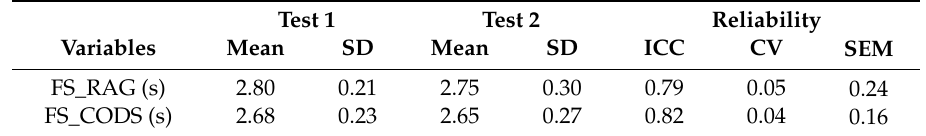
Table 1. Inter-testing reliability of the newly developed tests of reactive agility and change of direction speed (n = 14).